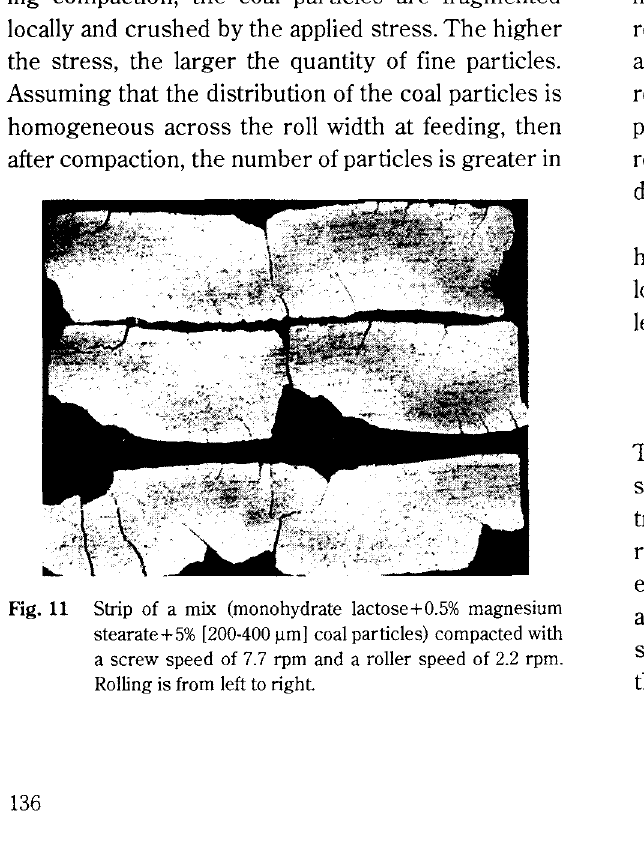
Fig. 11 Strip of a mix (monohydrate lactose+0.5% magnesium stearate+5% [200-400 )liD] coal particles) compacted with a screw speed of 7.7 rpm and a roller speed of 2.2 rpm. Rolling is from left to